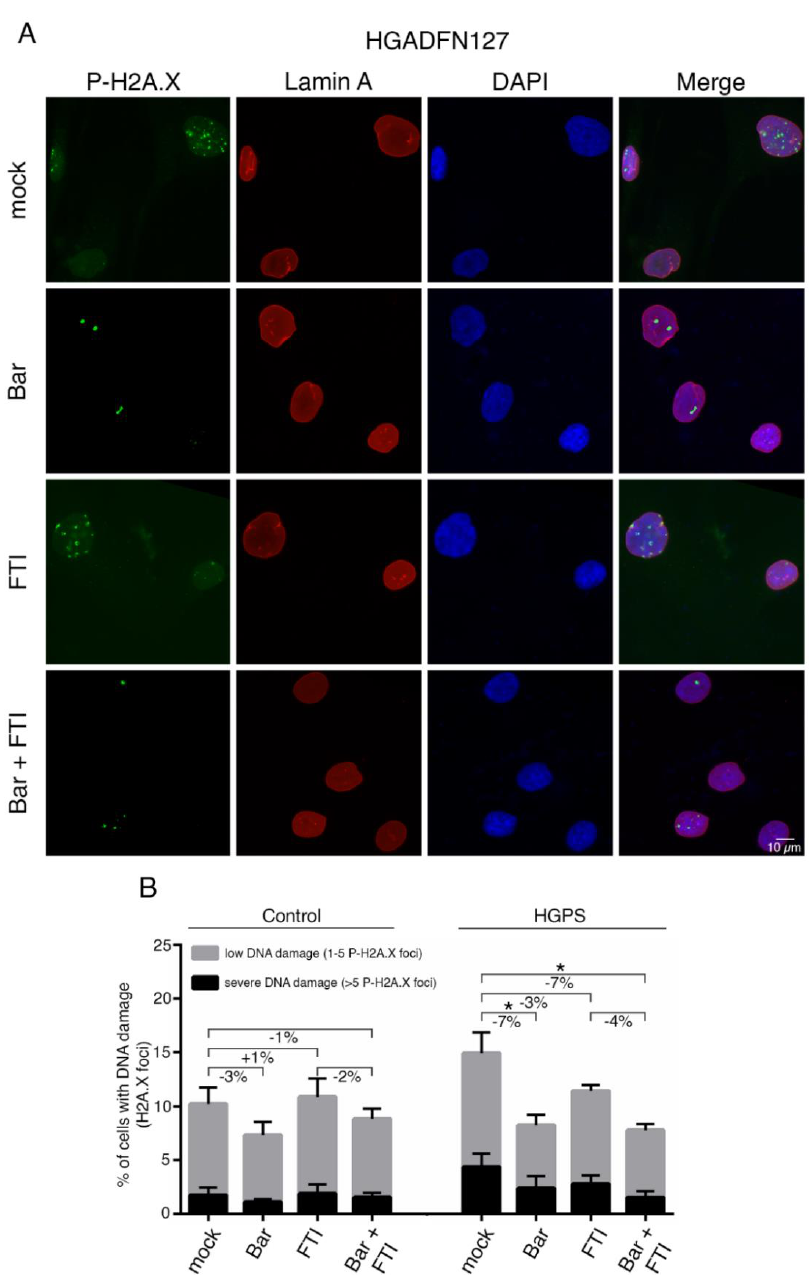
Figure 5. Bar and FTI combination treatment reduce P-H2A.X levels in HGPS cells. ( A ) Representative immunofluorescence images of HGPS HGADFN127 fibroblasts treated for nine days as indicated. Antibodies against P-H2A.X (green) and lamin A (red) were used, and DNA was stained with DAPI. Fluorescence images were taken at 60 × magnification. Scale bar: 10 µ m. ( B ) Number of nuclei with low DNA damage (1–5 P-H2A.X foci) and severe DNA damage (>5 P-H2A.X foci) in control and HGPS cultures treated as indicated. Graphs show mean ± SD. ( n = 3; * p <